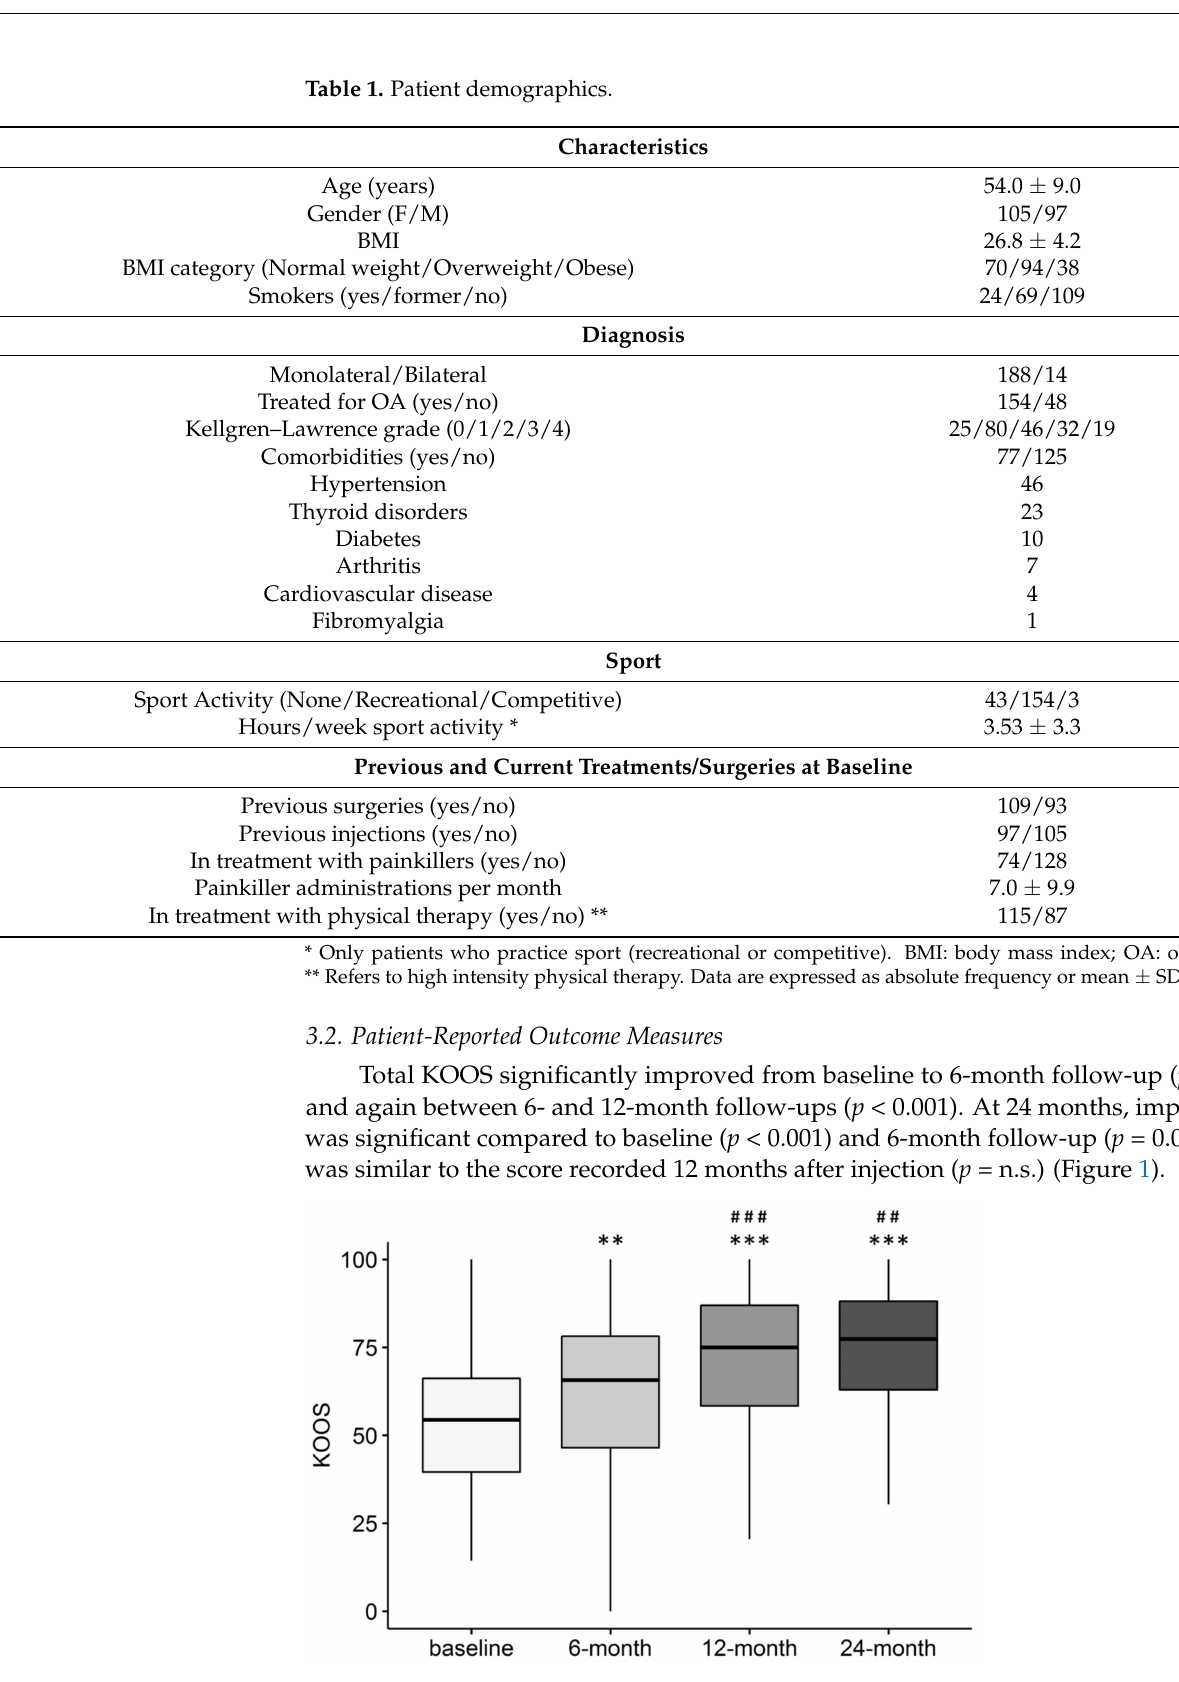
Figure 1. Total KOOS score over time in patients treated with intra-articular injection of